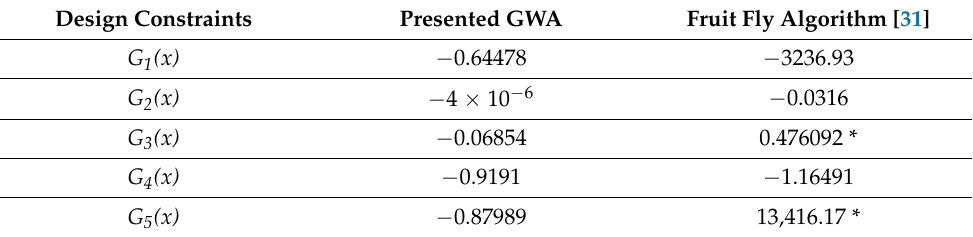
Table 3. Constraints justification based on presented GWA versus Fruit Fly Algorithm [31] for TLSM design under first